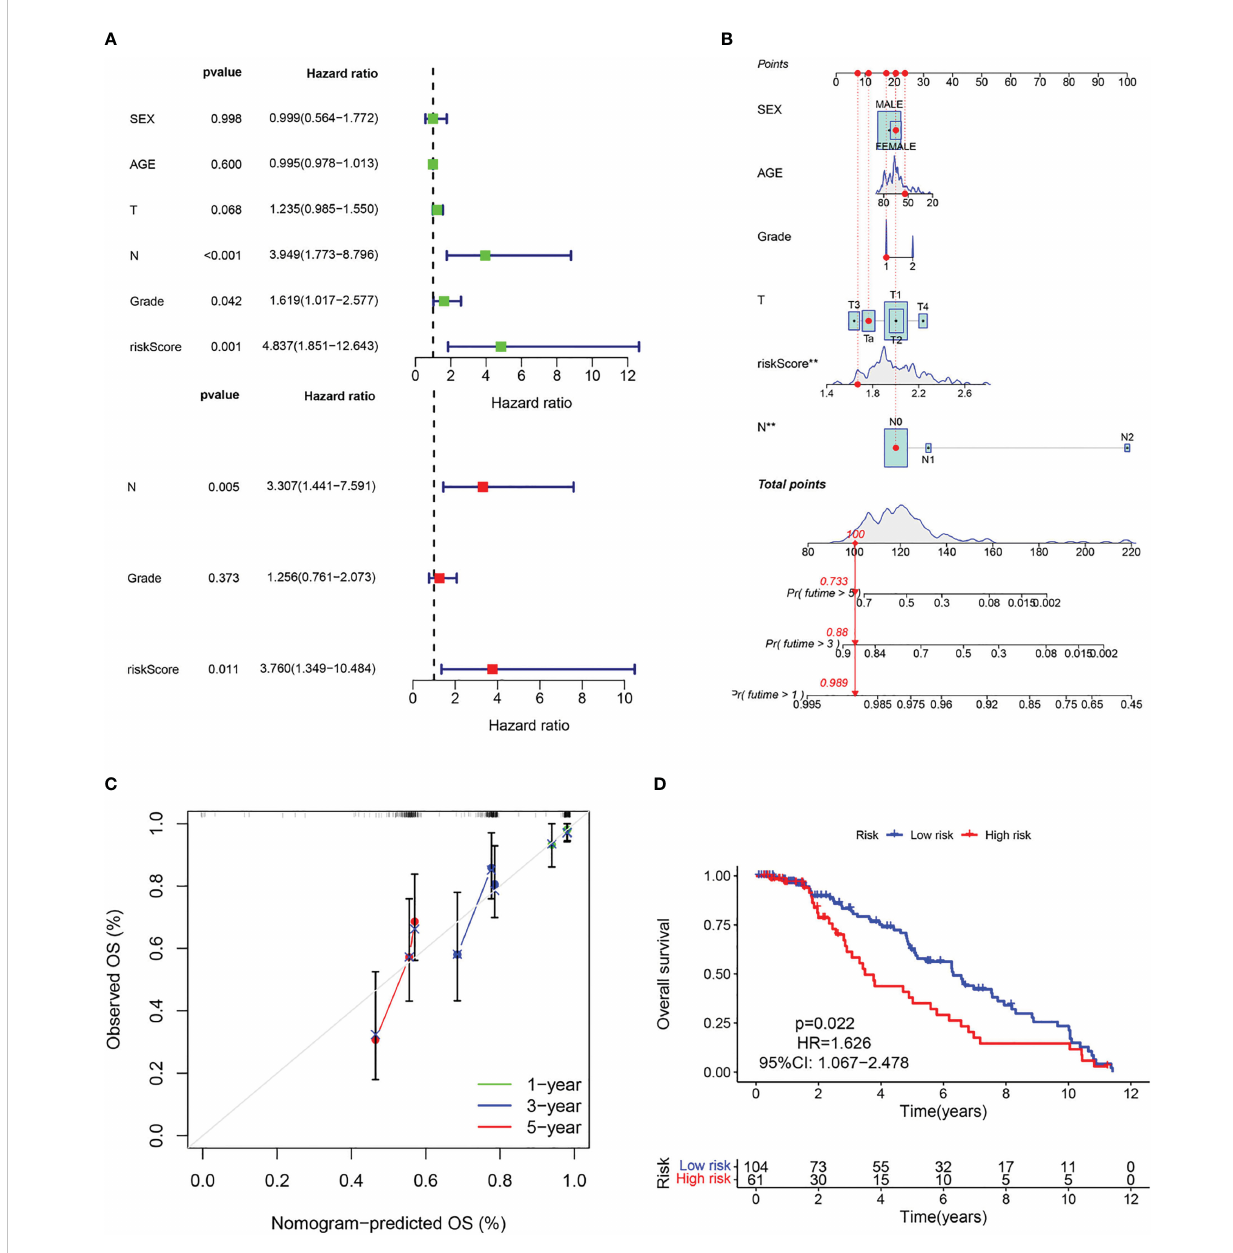
FIGURE 8 Evaluation of the predictive capability of CAF signature based the GEO cohort. (A) Forest maps of the univariate and multivariate Cox regression analysis between the CAF-riskScore and clinical characteristics. (B) Nomogram predicting the survival rate at 1, 3, 5 years for BLCA patients, and **p< 0.001. (C) Calibration plots for the nomogram. (D) Kaplan – Meier survival curve for the CAF-risk